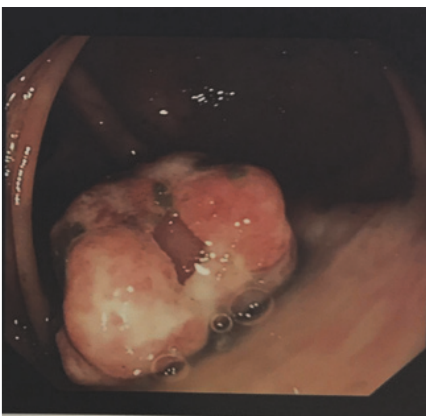
Figure 1: Large friable pedunculated polyp.